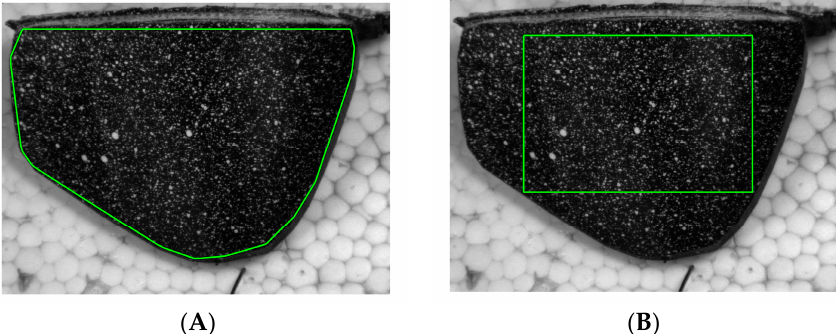
Figure 3. ( A ) 3D printed object with the applied speckle pattern and the ROI (green) used to reconstruct 3Dsurf3DM; ( B ) Sub-region on the 3D printed model used to assess the accuracy of the rigid registration process.